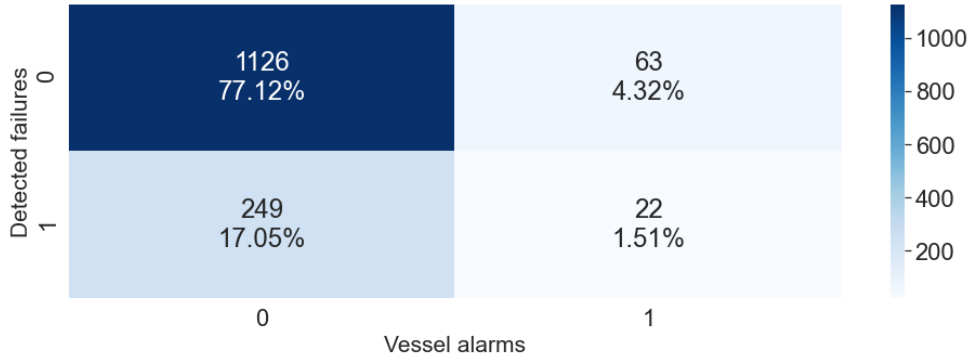
Figure 9. Confusion matrix comparing detected failures vs. vessel alarms for the power-generation engine in the F-100 class